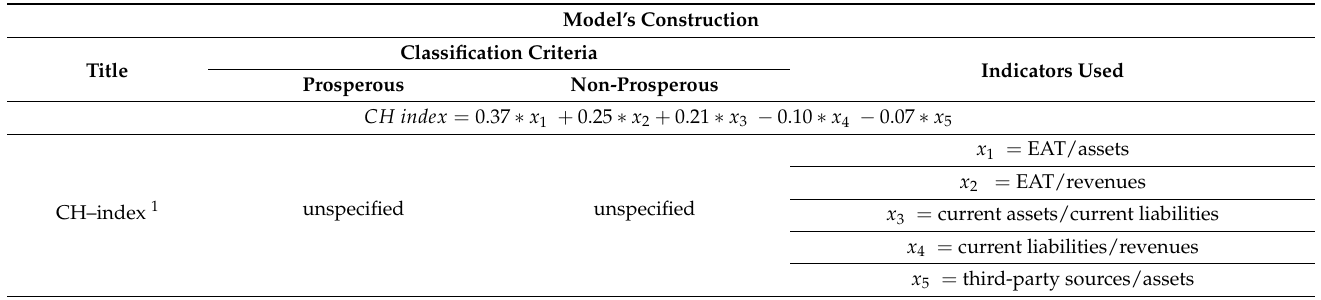
Table A1. Parameters of local default prediction